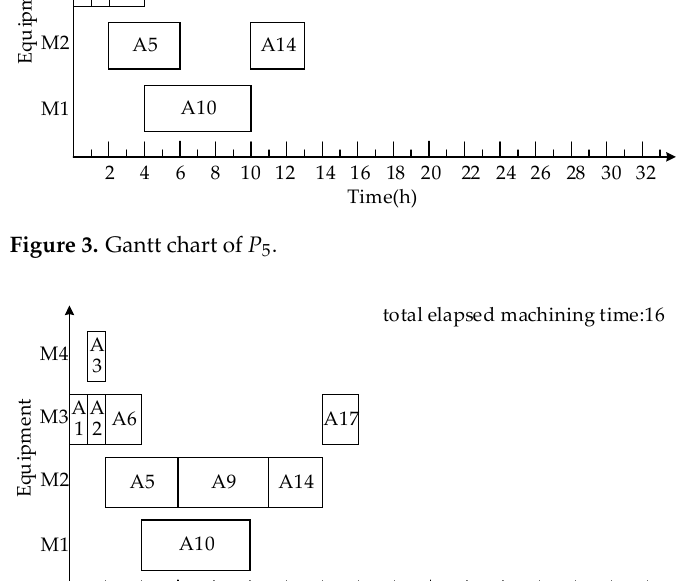
Figure 4. Gantt chart of P 61 .